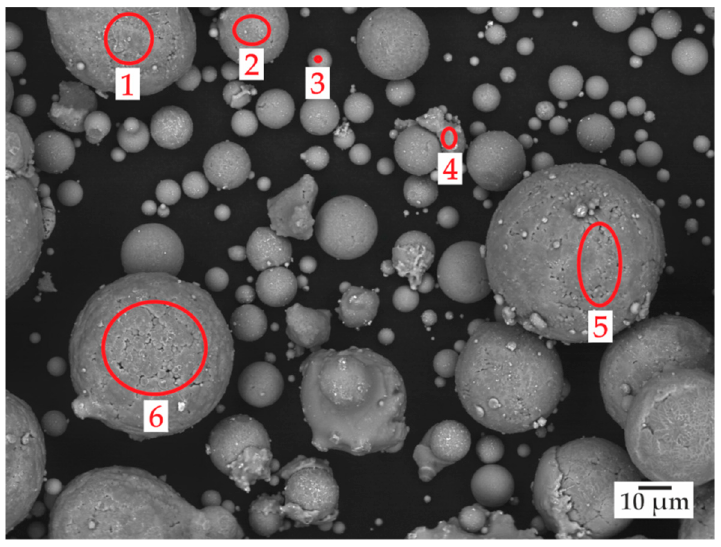
Figure 8. AlZn22Si6 powder with marked measuring areas 1 to 6 (EDS results in Table 5). Table 5. Results of the EDS measurement for the areas 1 to 6 from Figure 8 in at.%; the regions of interest (ROI) are marked in Figure 8; the relative error of the individual measurements is less than 5%.